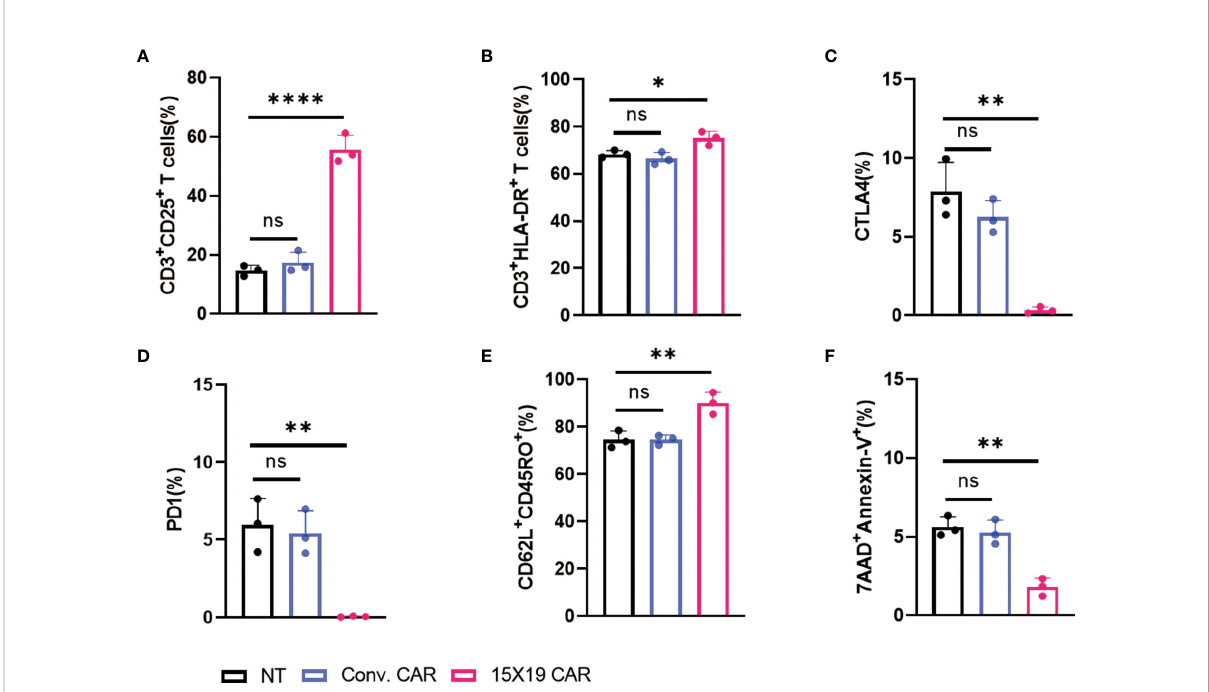
FIGURE 3 Phenotypic characterization of 15 × 19 CAR T cells. (A) , A higher proportion of CD3 + CD25 + cells is detected in the 15 × 19 CAR group than in the NT and conventional CAR groups; (B) , A higher proportion of CD3 + HLA-DR + cells is detected in the 15 × 19 CAR group than in the NT and conventional CAR groups; (C) Lower CTLA4 expression is detected in the 15 × 19 CAR group than in the NT and conventional CAR groups; (D) , Lower PD1 expression is detected in the 15 × 19 CAR group than in the NT and conventional CAR groups; (E) A higher proportion of CD62L + CD45RO + cells is detected in the 15 × 19 CAR group than in the NT and conventional CAR groups; (F) A lower apoptotic rate is seen in the 15 × 19 CAR group than in NT and conventional CAR groups. Data are presented as means ± SD from three independent experiments, and one-way ANOVA with Bonferroni ’ s correction is used for comparison of the percentage of phenotypic characterization. ns , no signi fi cant difference; * P < 0.05; ** P < 0.01; **** P <